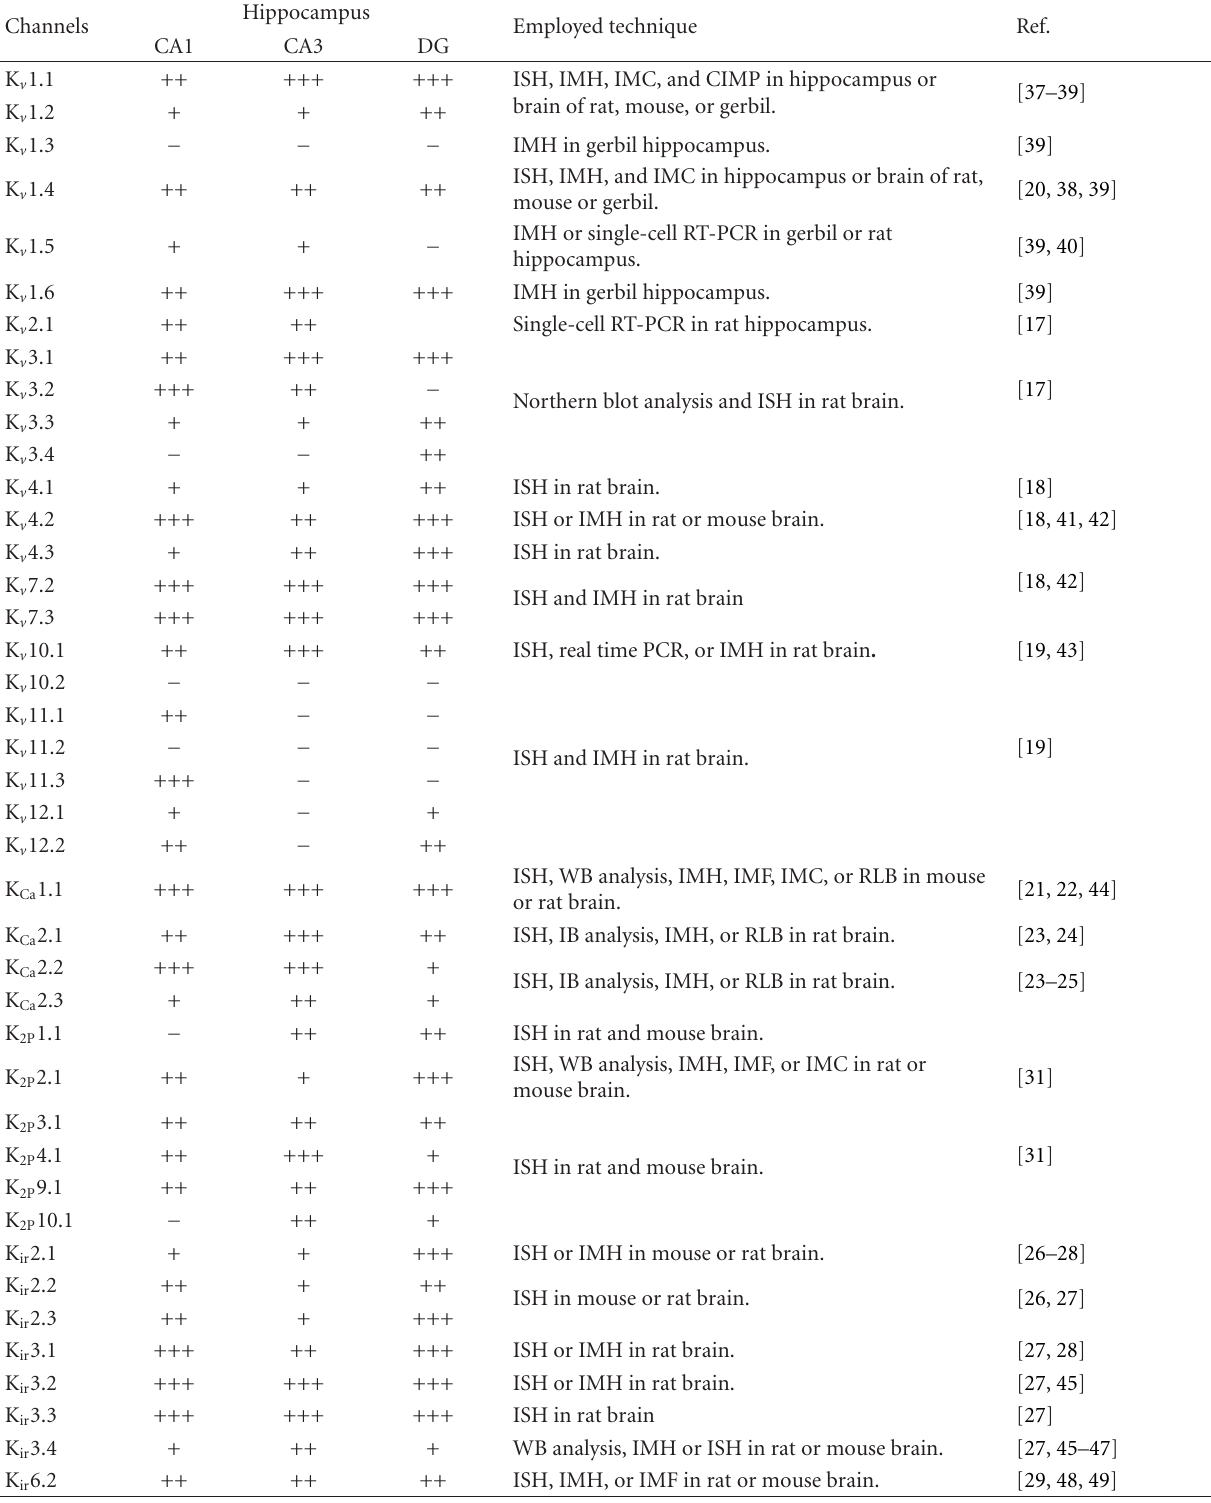
Table 1: Distribution of di ff erent types of K + channels in